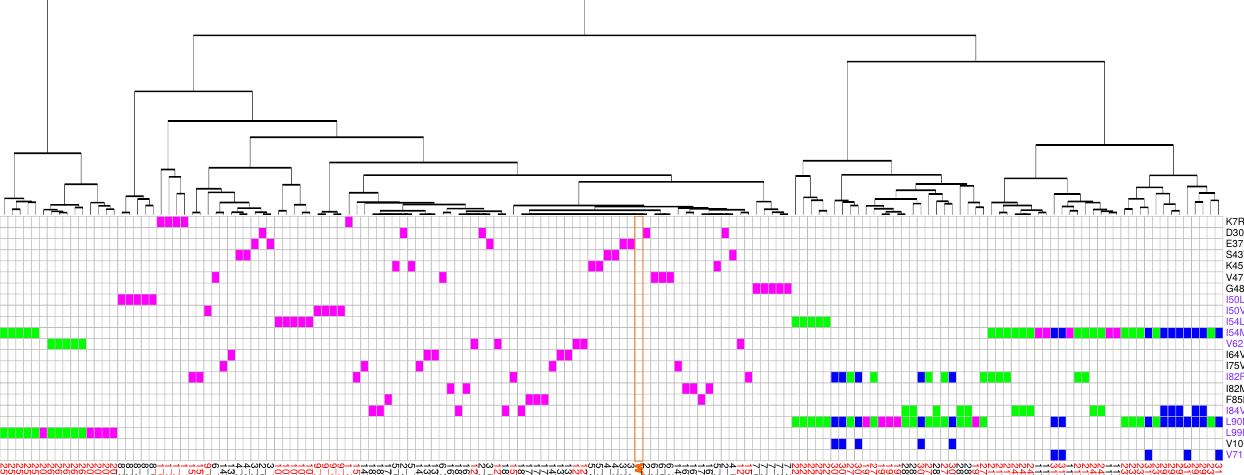
Figure 7. Classifications of the 156 structures according to their similitude of their interface. The table provides the description of each mutant structure in terms of mutations. Mutant structures are ranked according to their apparition in the classification. Single mutants are colored in magenta, double mutants in green and triple mutants in blue. The orange column locate the wild-type interface. Mutations colored in purple are invoved in the interface. Residues colored in red correspond to MCS atoms in the